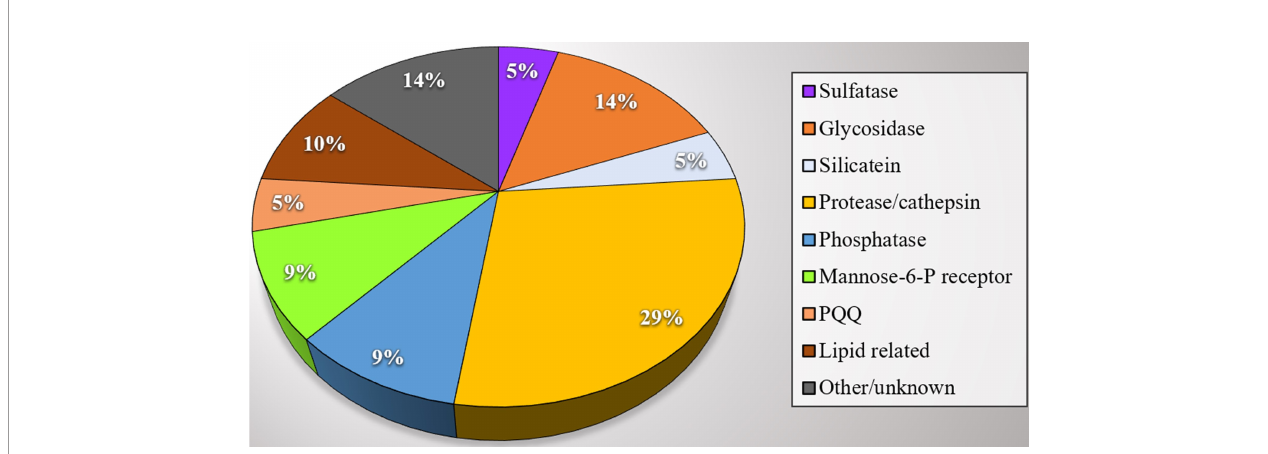
FIGURE 2 | Proteins extracted from P. fi ciformis biosilica. Subdivision of proteins in activity categories. Each colour is representative of a category group and the numbers inside the circle areas indicate the numbers of proteins of the same category.